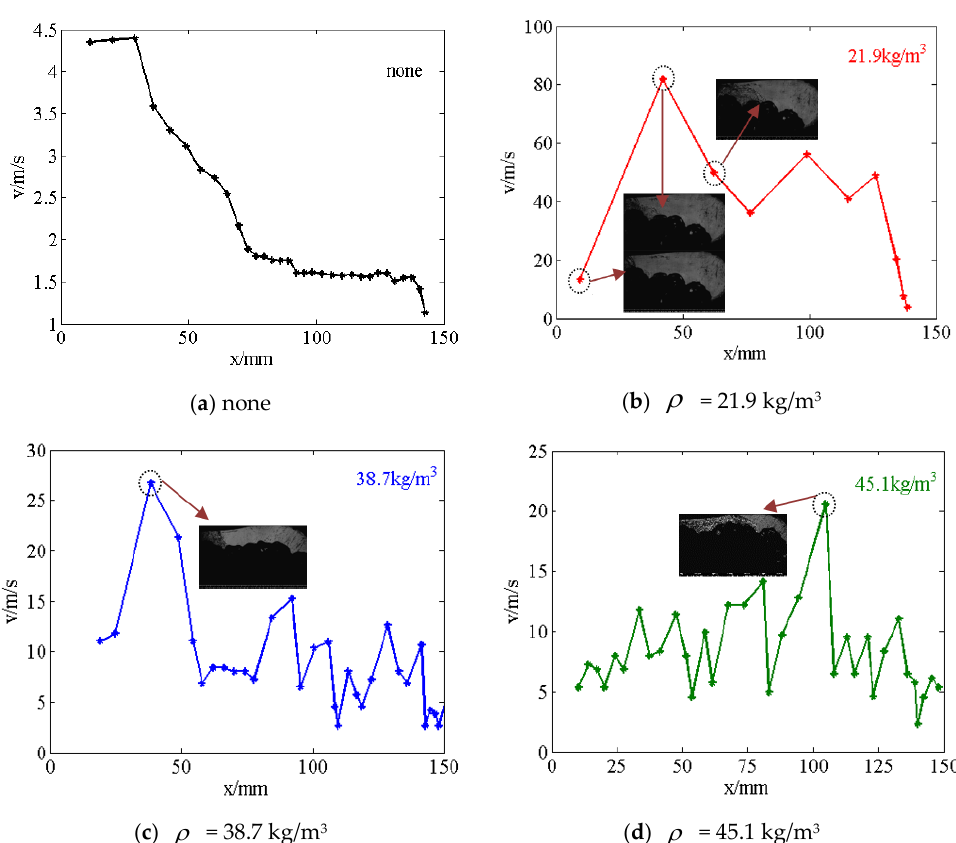
Figure 7. Flame tip velocity under different filling densities at initial pressure of 0.3 MPa.